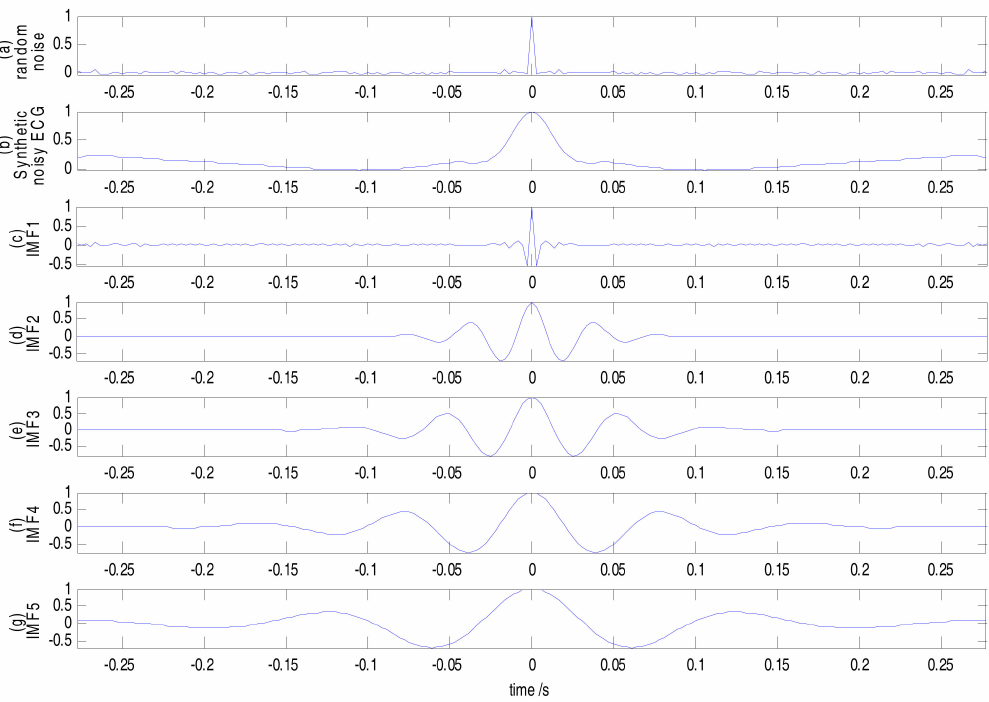
Figure 4. Partial autocorrelation function plots of the synthetic noisy ECG